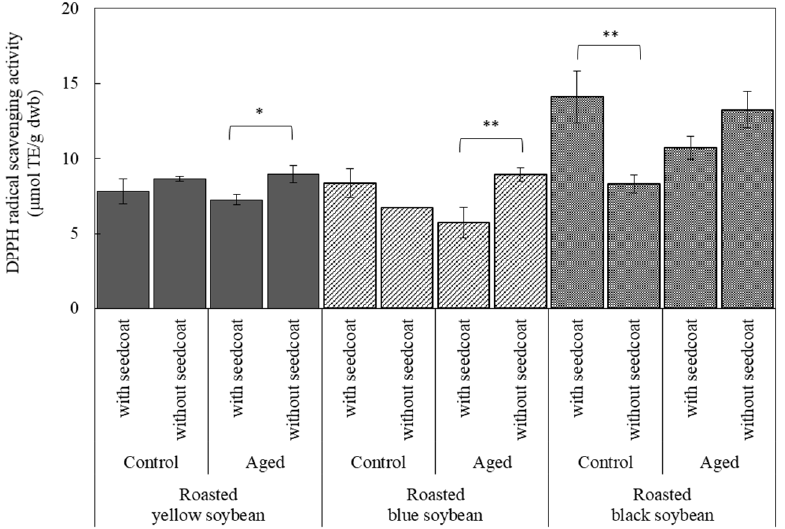
Figure 6. Effect of seed coat on DPPH radical scavenging activity of roasted soybeans before and after storage. Storage condition: Control were kept in a refrigerator (4 °C) for 60 days; Aged beans were stored at 30 °C/75% RH for 60 days. Roasting condition was 190 °C for 20 min. * indicates that there is significant difference between with seed coat and without seed coat in the same beans. * p < 0.05 ** p < 0.01. n = 6.